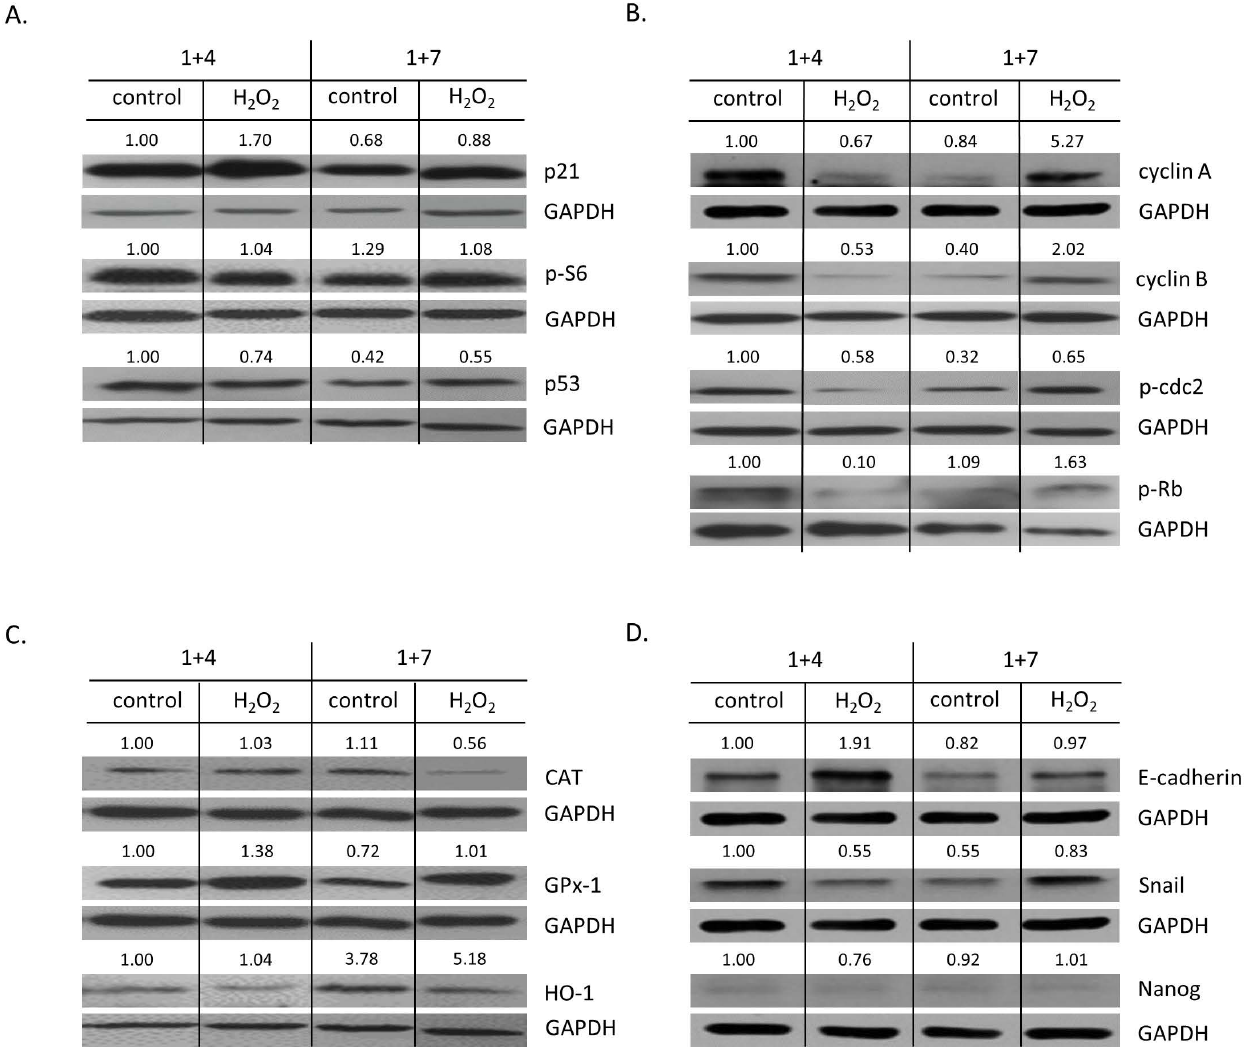
Figure 5. High H 2 O 2 level leads to escape from senescence: changed expression of proteins related to proliferation and EMT. Cells were subjected to 2.5 µ M of IRINO and 5 or 10 µ M H 2 O 2 . After 24 h, the medium was changed and the cells were cultured in a drug-free medium for 4 ( (cid:4) ) or 7 ( (cid:3) ) days. In a 7-day long variant of the experiment, after 4 days of cell culture, the medium was changed to the new one. ( A ) Production of protein related to cell cycle inhibition, geroconversion, and tumor suppression. Representative blots showing levels of p21, p-S6, and p53 proteins. ( B ) Production of proteins related to cell cycle progression. Representative blots show levels of cyclin A, cyclin B, p-cdc2, and p-Rb. ( C ) Production of antioxidative enzymes. Representative blots show levels of catalase, GPx-1, and HO-1 proteins. ( D ) Production of proteins related to EMT and stemness. Representative blots show levels of E-cadherin, Snail, and Nanog. GAPDH acts as a loading